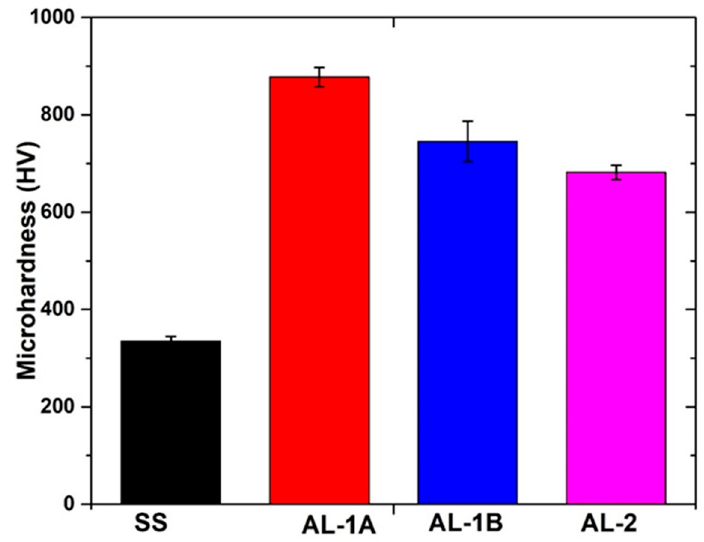
Figure 14. Vicker’s microhardness of the SS and IMC layers.